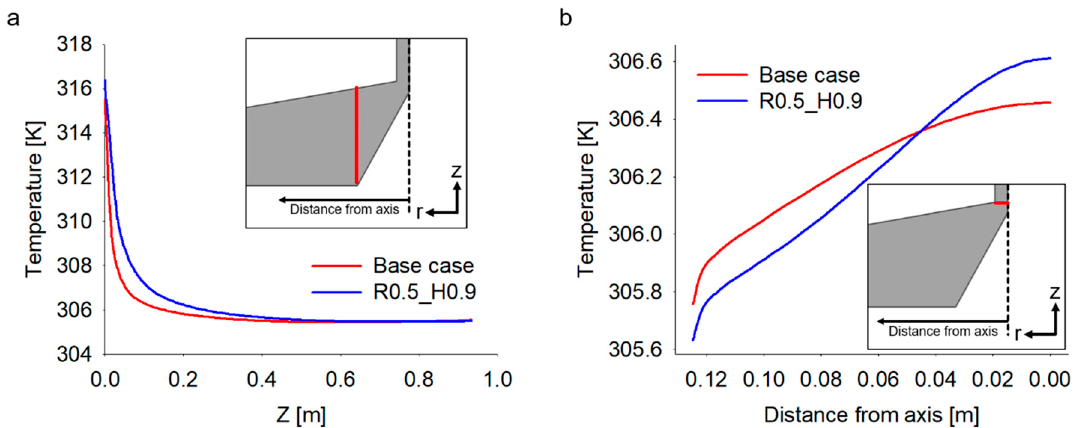
Figure 5. Comparison of the temperature at the center of the collector. ( a ) Temperature profiles along the z -axis on the red line in the inset. ( b ) Temperature profiles along the distance from the axis on the red line in the inset.